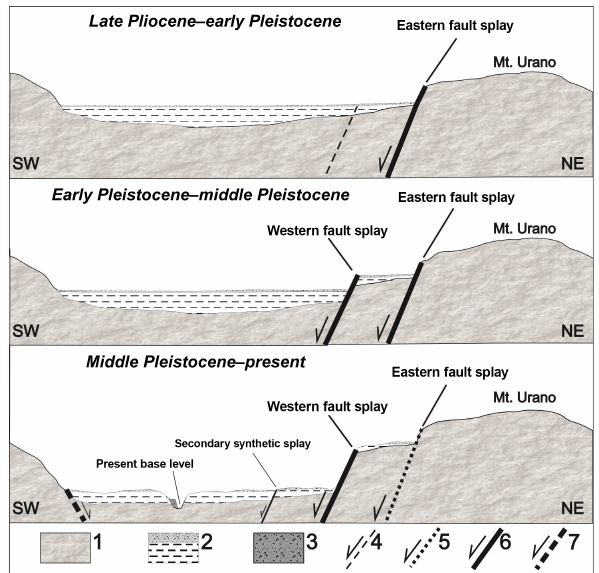
Figure 4. Scheme of the Quaternary structural evolution of the Subequana Valley fault and of Mt Urano southwestern slope. (1) Carbonate bedrock, (2) lacustrine sequence, (3) fluvial-alluvial deposits, (4) incipient normal fault, (5) inactive normal fault or nor- mal fault whose current activity is presently uncertain, (6) active normal fault, and (7) supposed antithetic normal